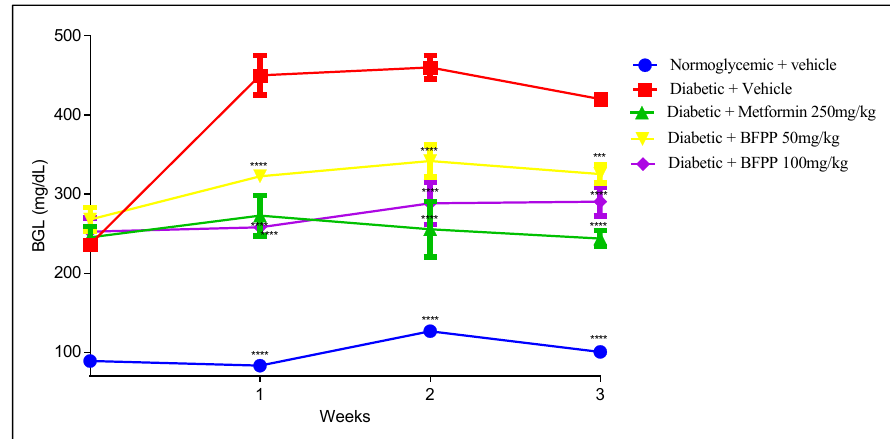
Figure 2. Blood glucose levels (BGL) of animals treated for 21 days. Normoglycemic (blue), vehicle (red), metformin 250 mg/kg (green), BFPP 50 mg/Kg (yellow), BFPP 100 mg/Kg (purple). The data are expressed as mean ± SEM, n = 6 animals per group. Two-way ANOVA post-test Bonferroni; *** p < 0.001 and **** p < 0.0001 compared with the vehicle group.